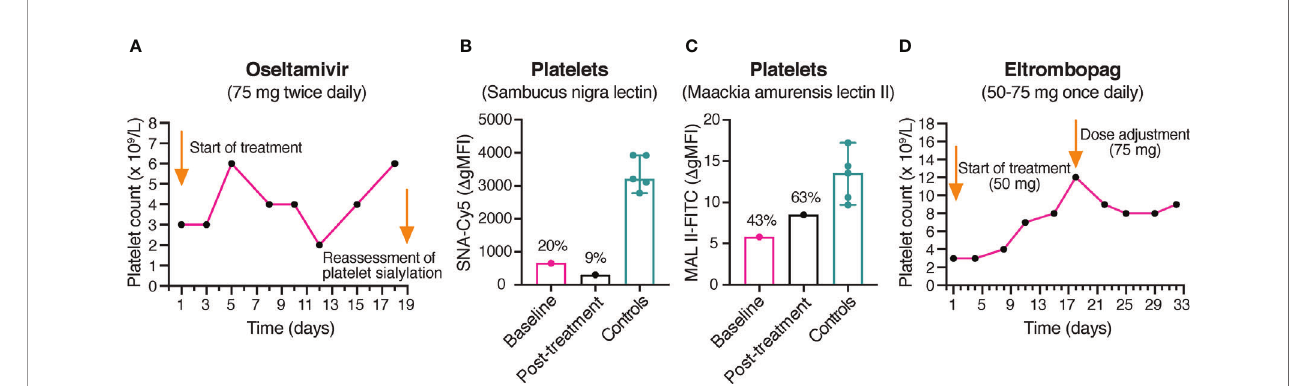
FIGURE 3 | Platelet counts during treatment with oseltamivir and eltrombopag. (A) Platelet counts in the proband during treatment with oseltamivir. The platelet counts of the proband were monitored during treatment with oseltamivir 75 mg twice daily. No clinically signi fi cant increase of the platelet count was observed after 17 days of treatment. (B, C) Reassessment of platelet sialylation after treatment with oseltamivir. a -2,6- and a -2,3-linked sialic acid was detected by fl ow cytometry using Cy5-labeled SNA (250 ng/mL) and FITC-labeled MAL II (100 m g/mL), respectively. A persistently decreased sialylation of platelets was observed in the proband following 18 days of treatment with oseltamivir. The results of the healthy controls ( n = 5) are shown as medians with min-max. The results in the proband are presented as percentages of the median D gMFI in the control group. (D) Platelet counts in the proband during treatment with eltrombopag. The platelet counts of the proband were monitored during treatment with eltrombopag 50-75 mg once daily. No clinically signi fi cant increase of the platelet count was observed after 31 days of treatment. SNA, Sambucus nigra lectin; MAL II, Maackia amurensis lectin II; gMFI, geometric mean fl uorescence